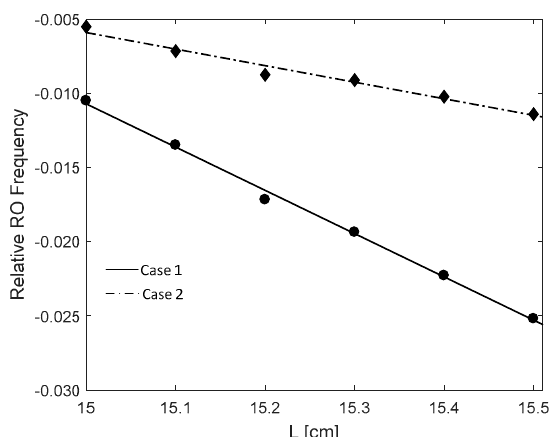
Figure 8. Fitting curves of the experimental results. RO: relaxation oscillation.